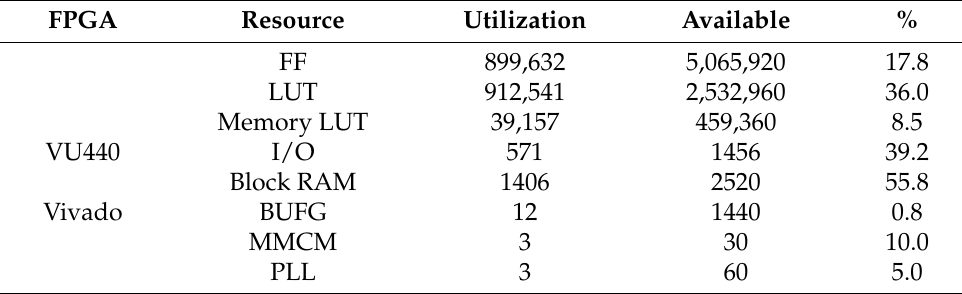
Table 4. Resource results of FPGA implementation.